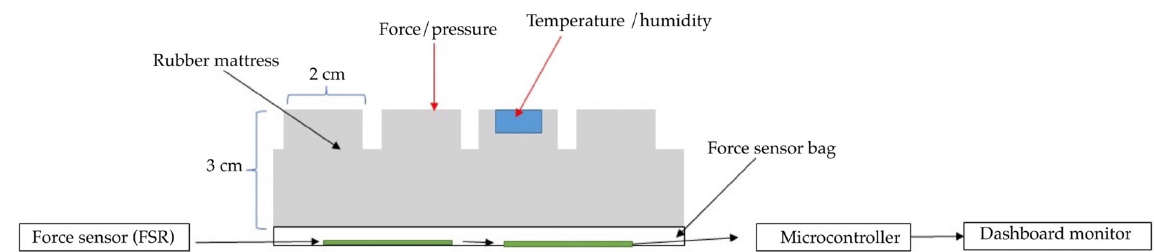
Figure 8. Force-sensitive mechanism.